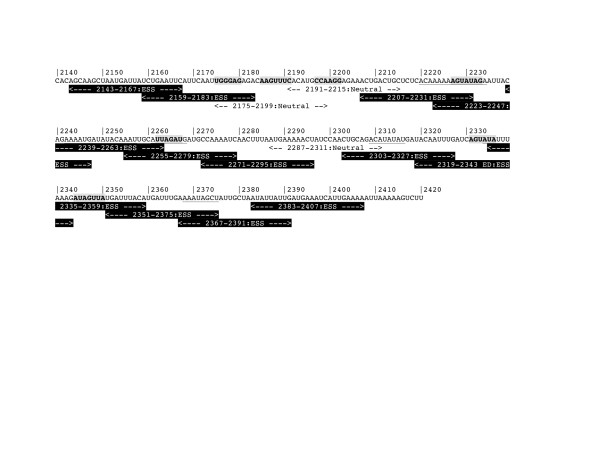
Activity of key ESS sequences in the context of HßΔ6. (A) The indicated sequences from exon 26 were cloned into the AccI site of exon 2 and tested for in vitro splicing activity (2 hour incubation, 30°C). 5% PAGE shown. Adjacent cartoons show identity of bands. (B) Quantification of splicing efficiency, normalised to HßΔ6 reporter. The bars show splicing efficiency, normalised to HßΔ6 for n=9 experiments, error bars show S.E.M. Overall one-way ANOVA shows p <0.0001. Comparison to HßΔ6 splicing efficiency for each construct by Bonferroni’s multiple comparison test: statistically significant differences shown by **= p <0.001.